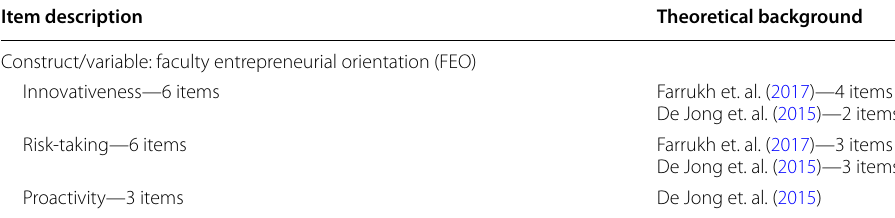
Table 2 Theoretical background/support for scale items, variables, and